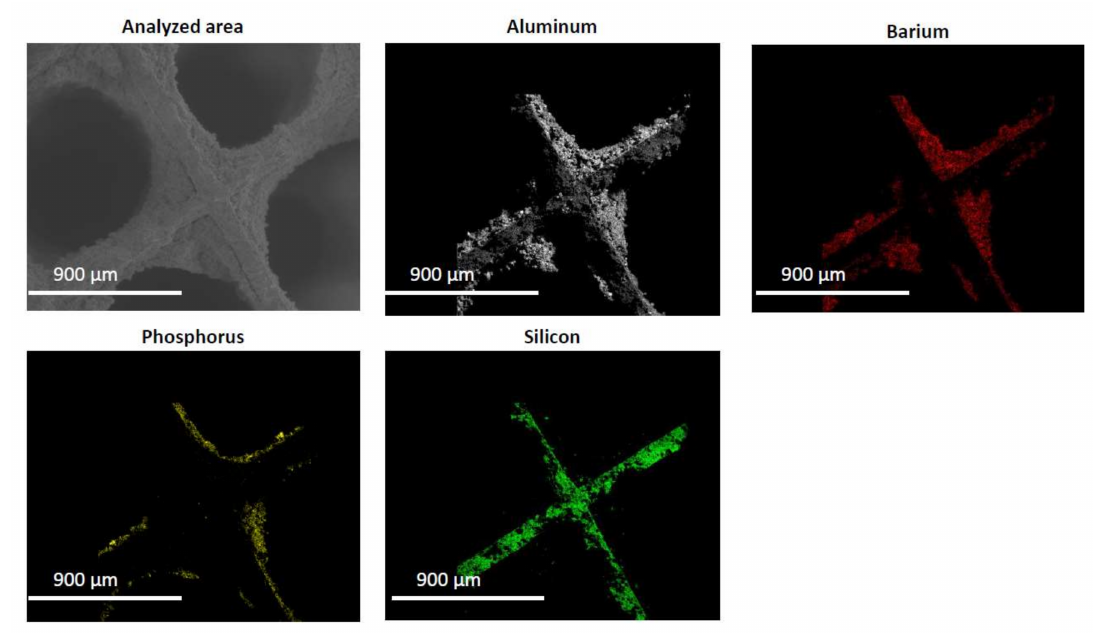
Figure 8. Environmental scanning electron microscopy (ESEM) and energy dispersive X-ray (EDX) images from the cross-section 2 mm from the front of the Pt/Ba/Al 2 O 3 sample exposed to 50 vol.-ppm H 3 PO 4 for 34